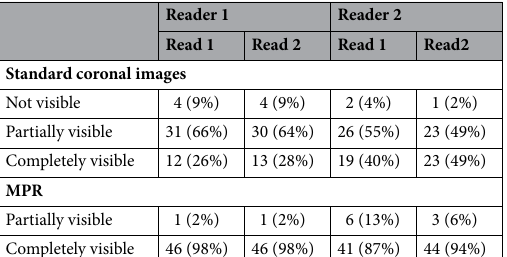
Reader 1 Reader 2 Read 1 Read